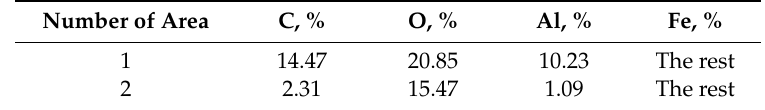
Table 6. The SEM analysis results of the FeGr1 + 1 wt% silicon carbide worn surface (Figure 16b, areas 1 – 3).